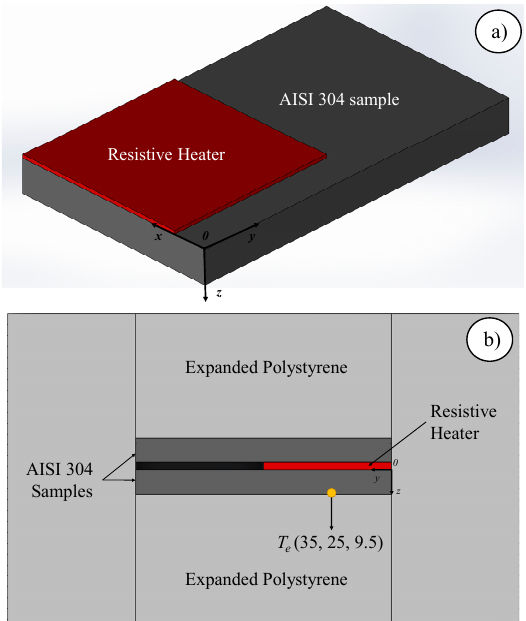
Figure 3. ( a ) Three-dimensional cut view of the experiment using AISI 304 stainless steel and ( b ) Symmetrical cut view assembly of the experiment with thermocouple.